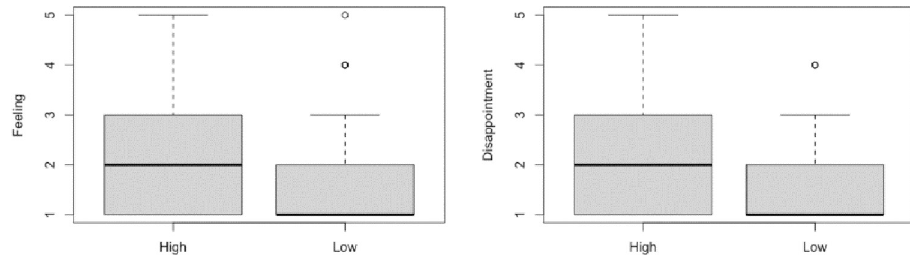
Fig 4. Box and whisker plots displaying the median and IQR of responses to the feeling and disappointment question in the two